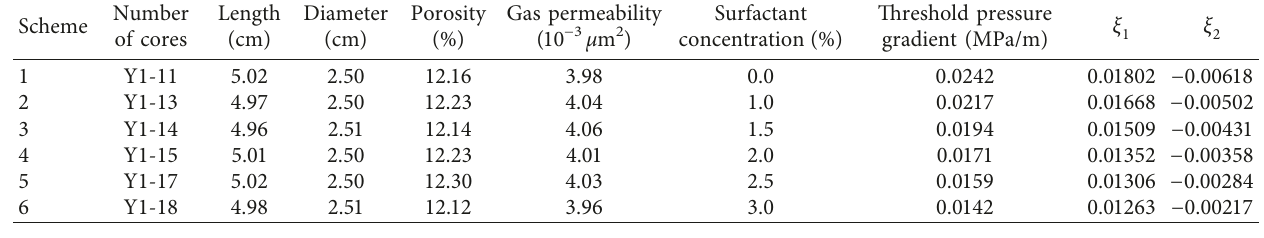
Table 1: The threshold pressure gradient of schemes in different surfactant concentrations.